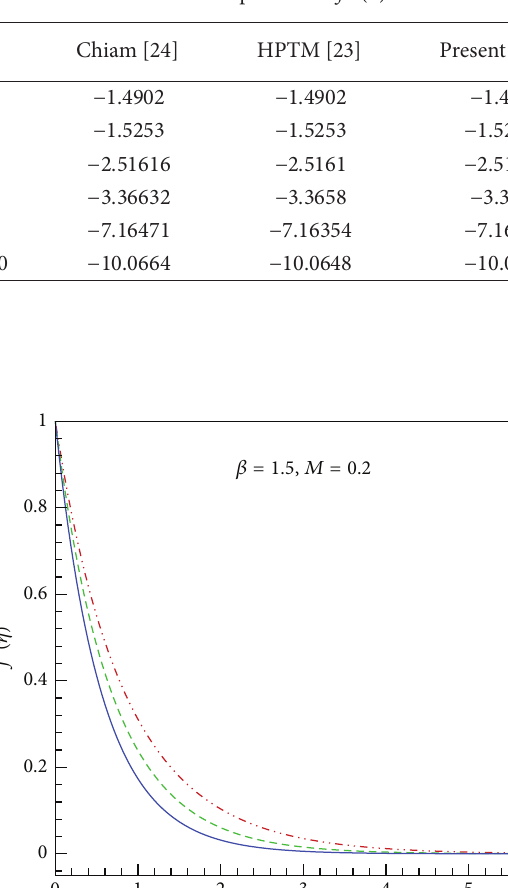
Table 2: Comparison of 𝑓 󸀠󸀠 (0) via OHAM with other methods for various values of 𝑀 at 𝐾 = 1 and 𝛽 = 1.5 .